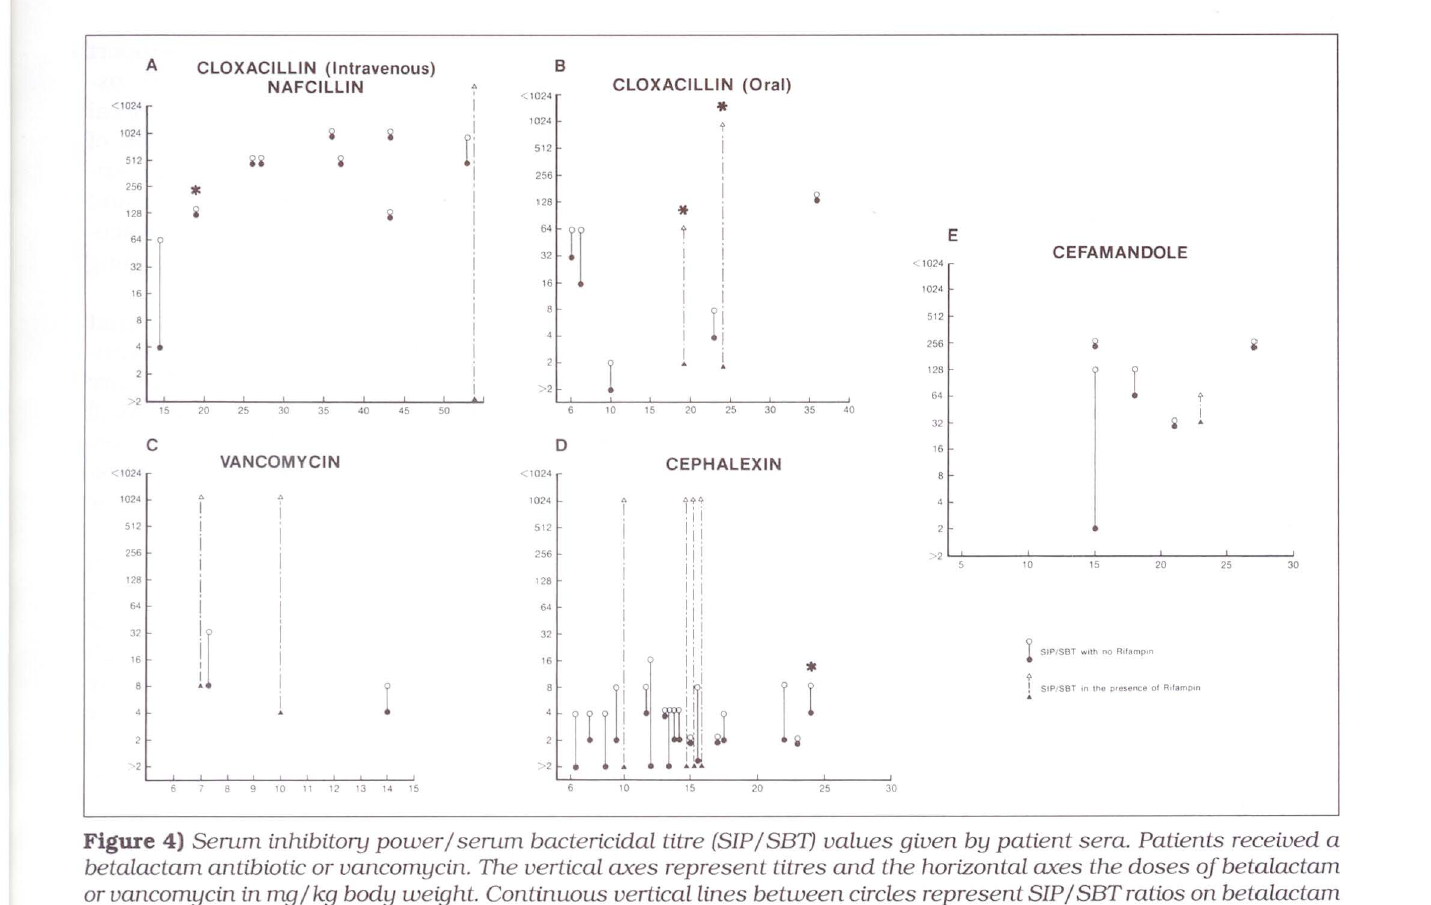
Figure 4) Serum inhibitory power I serum bactericidal titre (SIP I SBT) values given by patient sera. Patients received a betalactam antibiotic or vancomycin. The vertical axes represent titres and the horizontal axes the doses of betalactam or vancomycin in mg 1 kg body w eight. Continuous vertical lines between circles rep resent SIP I SBT ratios on betalactam or vancomycin alone, and dotted lines between triangles represent SIP I SBT on the same antibiotic plus rijampin. *These results w ere obtained from the two patients whose outcomes w ere worse than expected